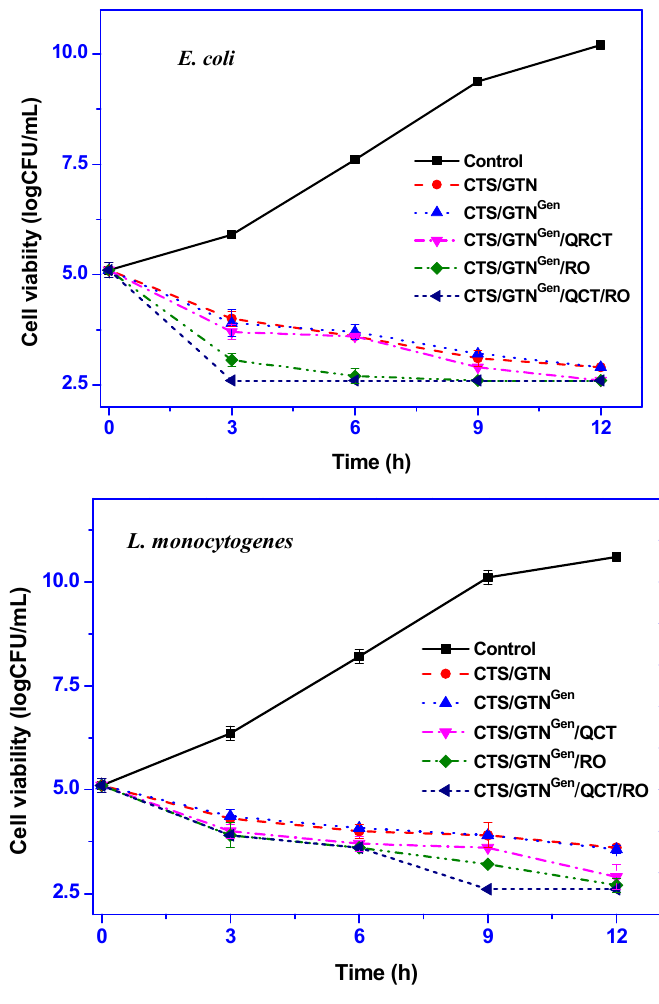
Figure 4. Antimicrobial activity of the chitosan/gelatin-based films against E. coli and L. monocytogenes .